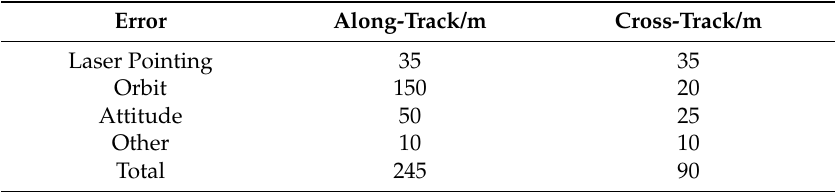
Table 2. Theoretic maximal error of rigorous geometric prediction model 1 . Error Along-Track/m Cross-Track/m Laser Pointing 35 35 Orbit 150 20 Attitude 50 25 Other 10 10 Total 245